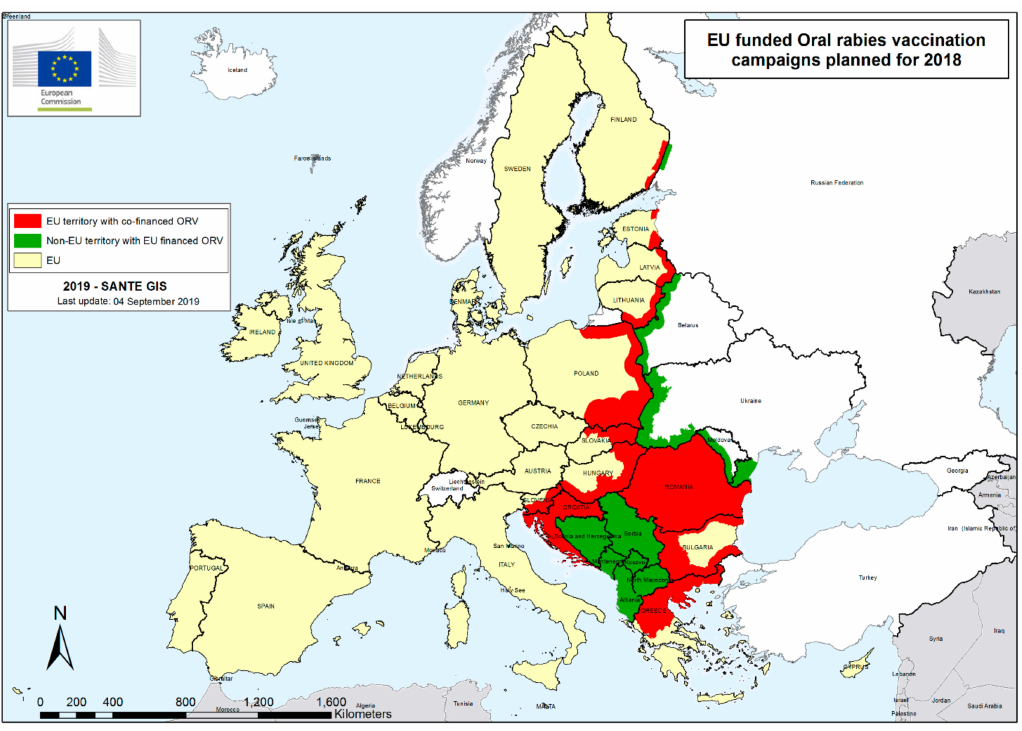
Figure 4. Oral rabies vaccination campaigns planned in